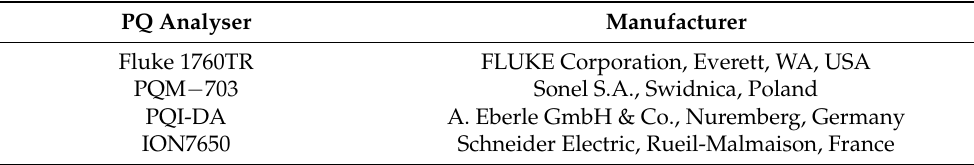
Table 10. PQ analysers were used for comparative